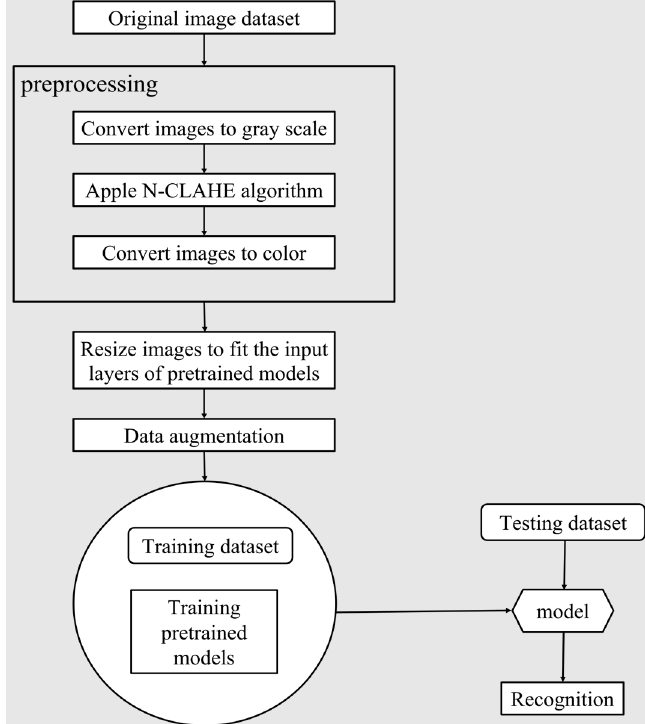
Figure 5. The pipeline of image preprocessing and model development. The original images are converted into gray scales and the N-CLAHE algorithm is applied, after which the images are converted back to color. The images need to be resized to fit the input layers of different models. Data augmentation, including image rotation and scaling, is applied to help fix the issue of limited dataset size. At last, the dataset is divided into the training and testing sets to validate the selected models.